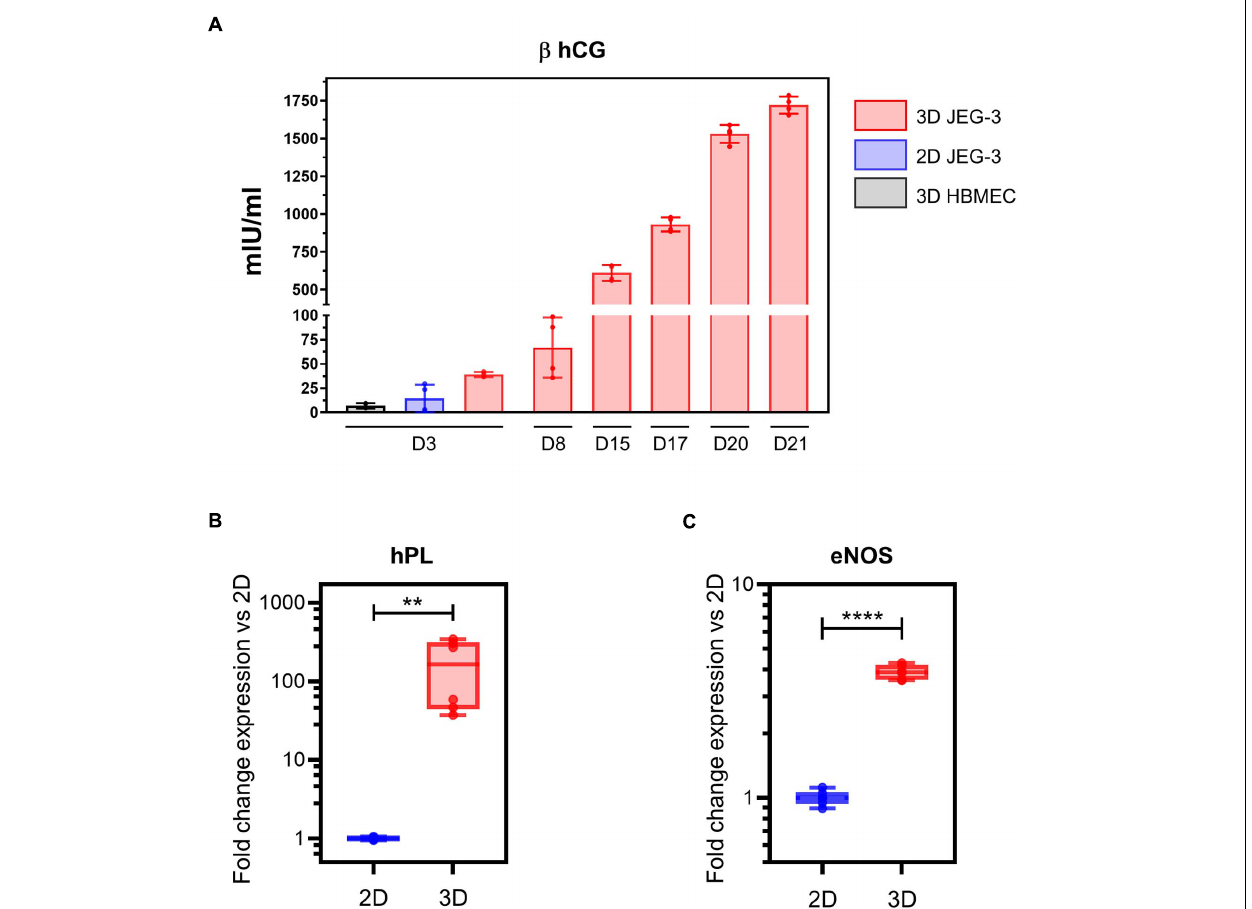
FIGURE 3 | 3D-cultured JEG-3 cells express markers associated with syncytiotrophoblasts’ differentiation. (A) ELISA assay for β human chorionic gonadotrophin ( β hCG) from culture supernatants of 2D JEG-3 cells, 3D HBMECs and 3D-grown spheroid cultures, as indicated. Data represent the mean ± SD of two independent vessels or 2D cultures with samples tested in duplicates. (B) qRT-PCR analysis of human placental lactogen (hPL) mRNA from two independent vessels of spheroid cultures (3D) or conventional flasks of JEG-3 cells (2D). Fold change in gene expression was determined by the 2 − (cid:49)(cid:49) Ct method with samples normalized to β actin. Boxes represent first and third quartiles with a line at the median. Whiskers indicate maximum and minimum data values. (C) qRT-PCR analysis of endothelial nitric oxide synthase (eNOS) mRNA from two independent vessels of spheroid cultures (3D) or conventional flasks of JEG-3 cells (2D). Fold change in gene expression calculated and plotted as in (B) . In all panels, asterisks indicate statistically significant differences calculated by the unpaired t -test. ** P ≤ 0.01; **** P ≤ 0.0001.